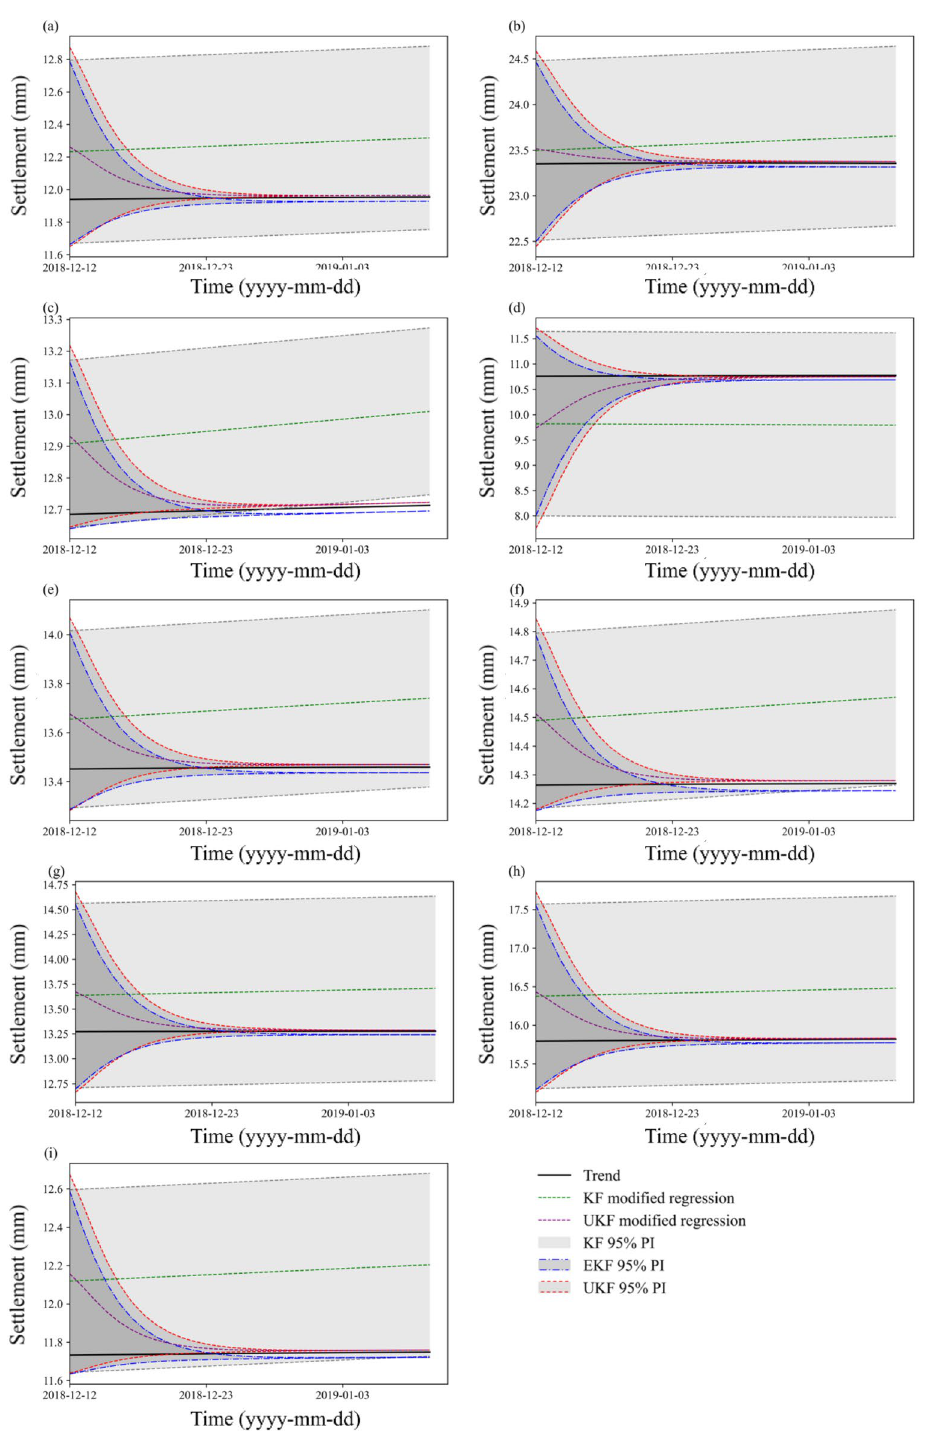
Figure 11. PIs with real-time correction by KF, UKF and EKF: ( a ) TP1-1; ( b ) TP1-2; ( c ) TP1-3; ( d ) TP2-1; ( e ) TP2-2; ( f ) TP2-3; ( g ) TP3-1; ( h ) TP3-2; and ( i )